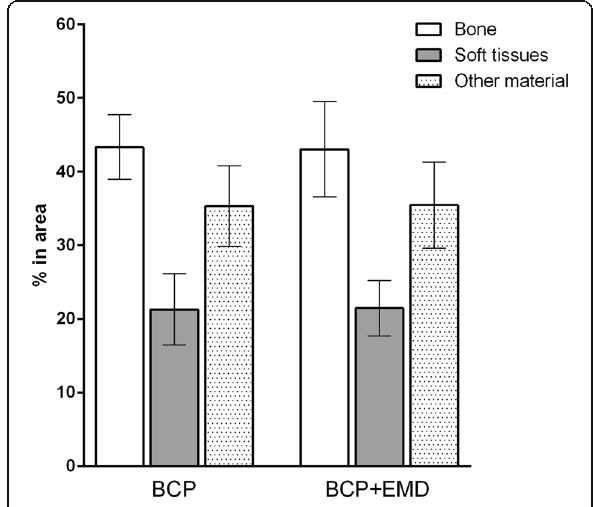
Fig. 6 Histomorphometric evaluation results (considering six sections for each biopsy), for newly formed bone, soft tissues, and